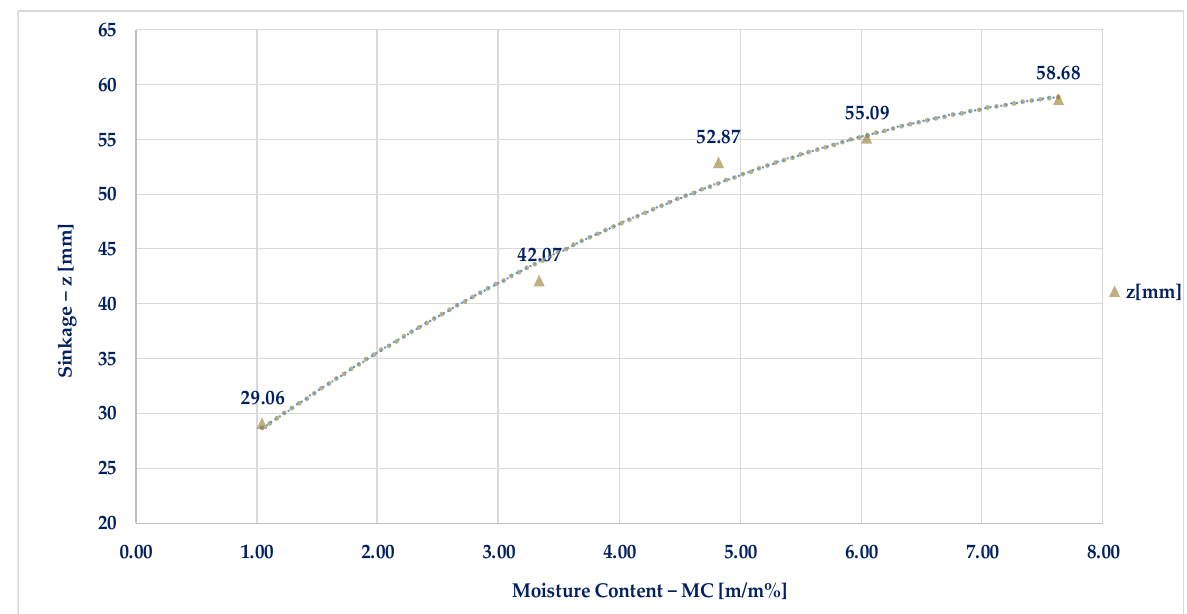
Figure 7. The change in the sinkage of sandy loam soil with moisture content under the maximum applied load (25 bar).